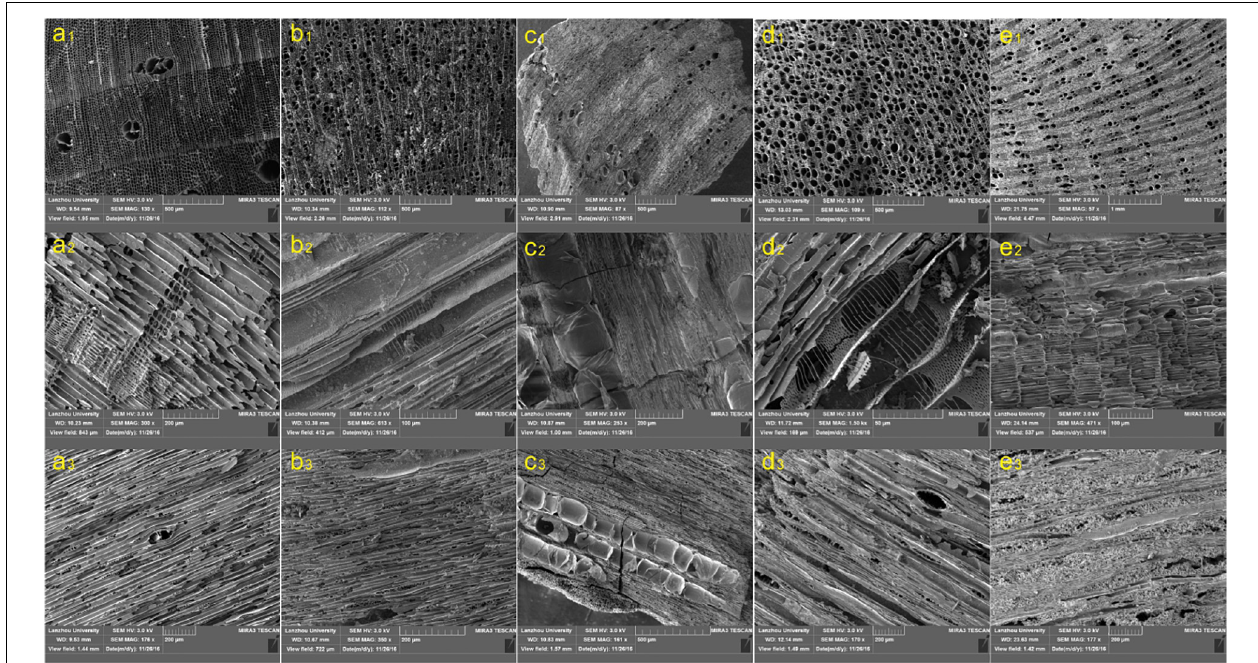
FIGURE 3 | Charcoal remains identified at JBR. (a 1 ,a 2 ,a 3 ) Pinus L.; (b 1 ,b 2 ,b 3 ) Betula ; (c 1 ,c 2 ,c 3 ) Quercus ; (d 1 ,d 2 ,d 3 ) C arpinus cordata Bl.; (e 1 ,e 2 ,e 3 ) Tamarix L. (a) Transverse section of charcoal; (b) radial section of charcoal; (c) tangential section of